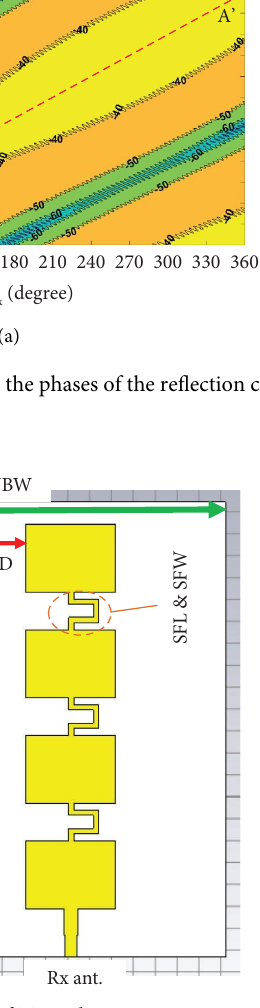
Figure 9: Geometry of Tx and Rx arrays. Table 1: Dimensions of the array antenna